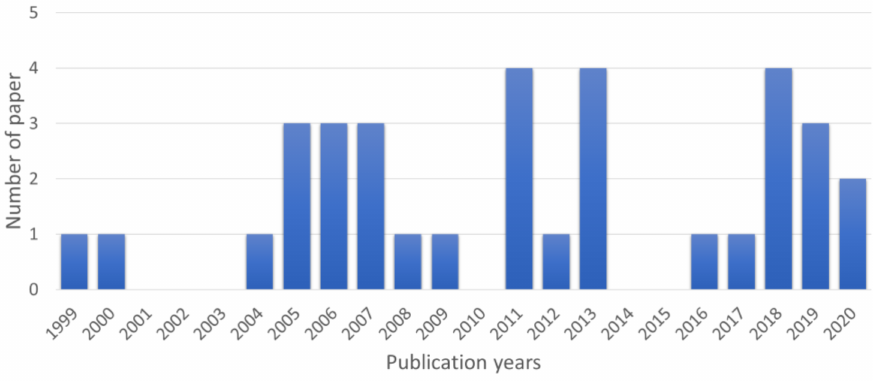
Figure 3. Number of papers published